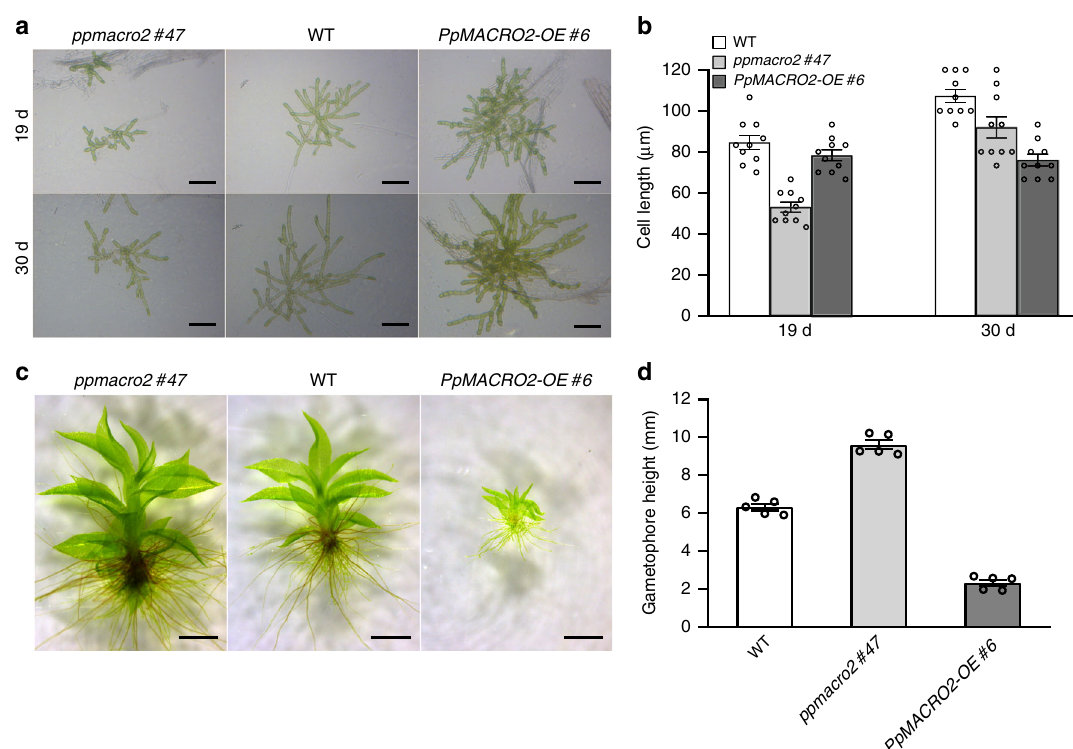
Fig. 2 PpMACRO2 affects sizes of protonemata and gametophores in P. patens . a , b Protonemal cell growth and elongation in WT, ko and OE plants. Protonemal cell length in ko mutants decreased by about 40% than in the wild type after 19 days, but there was no signi fi cant difference between OE lines and the wild type. After 30 days, protonemal cells in ko mutants were only about 15% shorter compared to the wild type, whereas protonemal cells of OE lines were about 30% shorter. These results show that protonemata grow much faster in ko mutants but slower in OE lines compared to the wild type between day 19 and day 30. Micrograph images shown were observed from at least three biological replicates. Data show means ± s.e.m. of ten biological replicates for WT and mutant plants. c , d Sizes of gametophores developed from four-week-old WT, ko , and OE plants. Gametophore heights were measured twice independently, with similar results. Micrograph images provided were observed from fi ve biological replicates. Data show means ± s.e.m. of fi ve biological replicates. Scale bar: 200 μ m in a ; 500 μ m in c